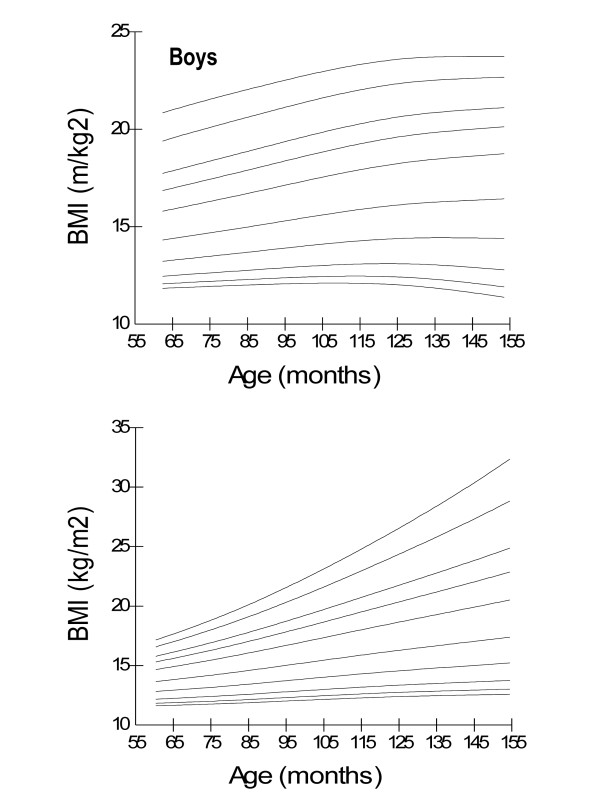
Smoothed BMI percentile curves for Pakistani primary school boys (n = 997) and girls (n = 883) aged five to twelve years. 5 years (61-71 months), 6 years (72-83 months), 7 years (84-95 months), 8 years (96-107 months), 9 years (108-119 months), 10 years (120-131 months), 11 years (132-143 months) and 12 years (144-155 months).